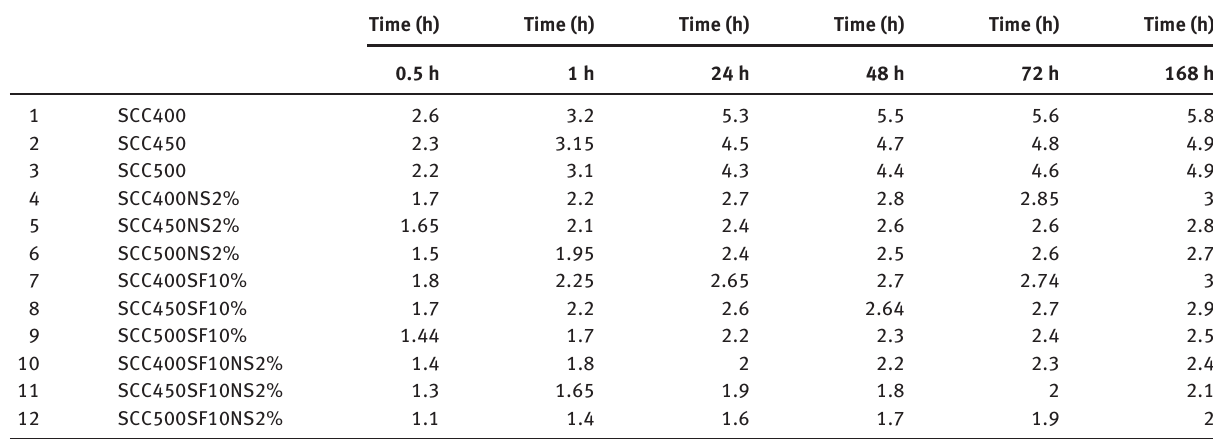
Table 4 Results of water absorption by